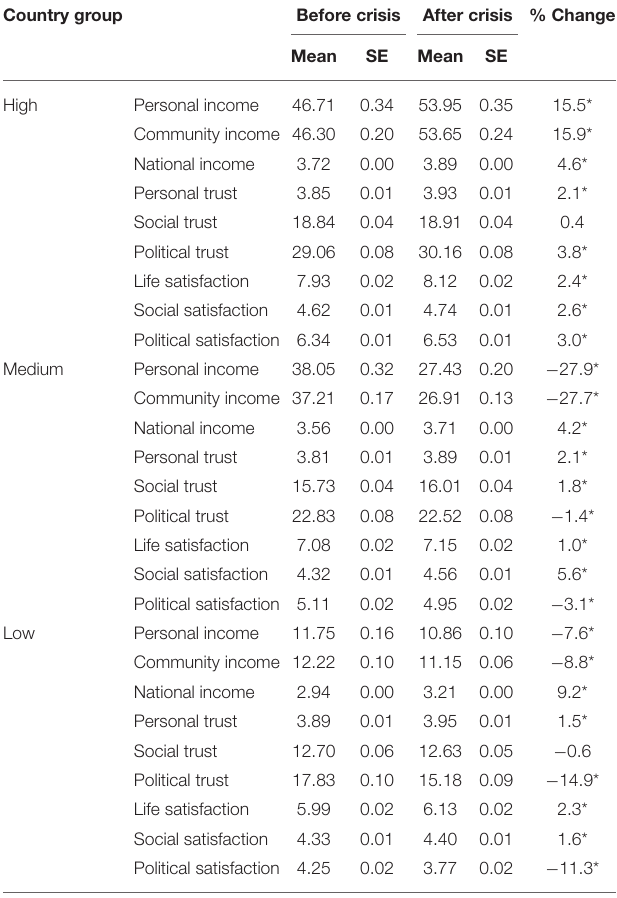
TABLE 2 | Weighted means of the primary variables of interest in the study before or after the financial crisis, with % change and significance of change by country group according to trust